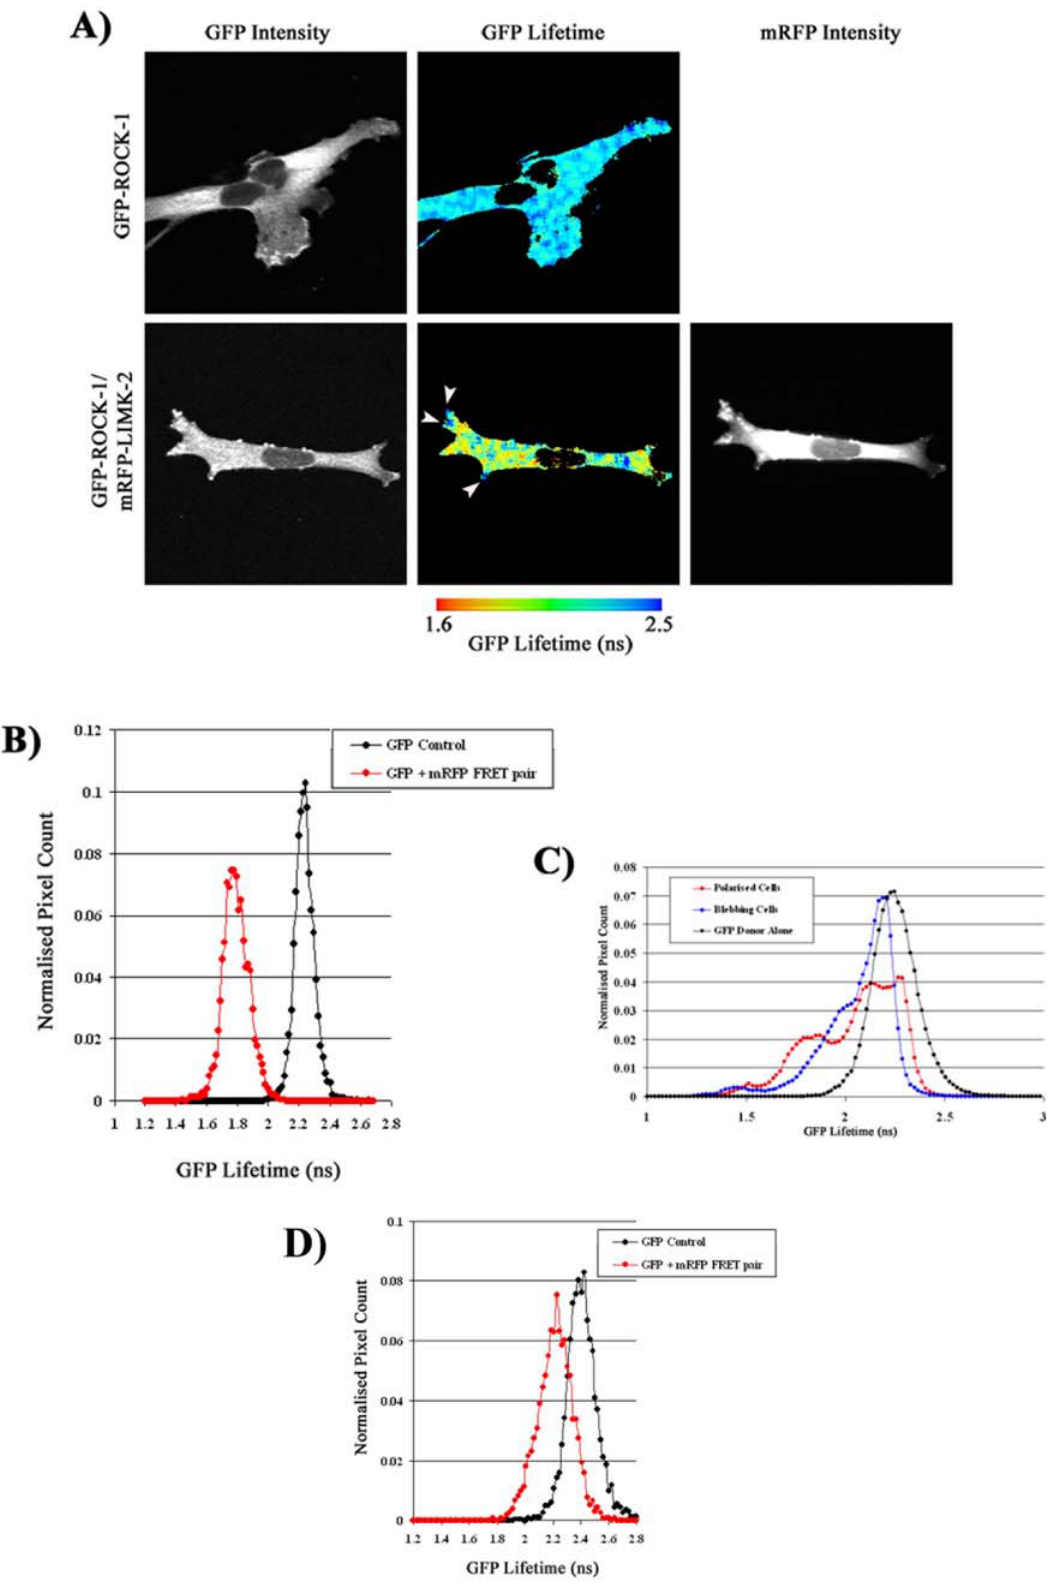
Figure 4. ROCK1 and LIMK2 interact in polarised cells. MDA-MB231 cells were microinjected with GFP-ROCK1 and mRFP-LIMK2, fixed, imaged and analysed using FLIM microscopy and the TRI2 analysis programme. A) Images of the GFP lifetime and GFP and mRFP intensities across a typical elongated cell was displayed for a cell expressing both the GFP-ROCK1 donor and the mRFP-LIMK2 acceptor and for comparison, only the GFP -